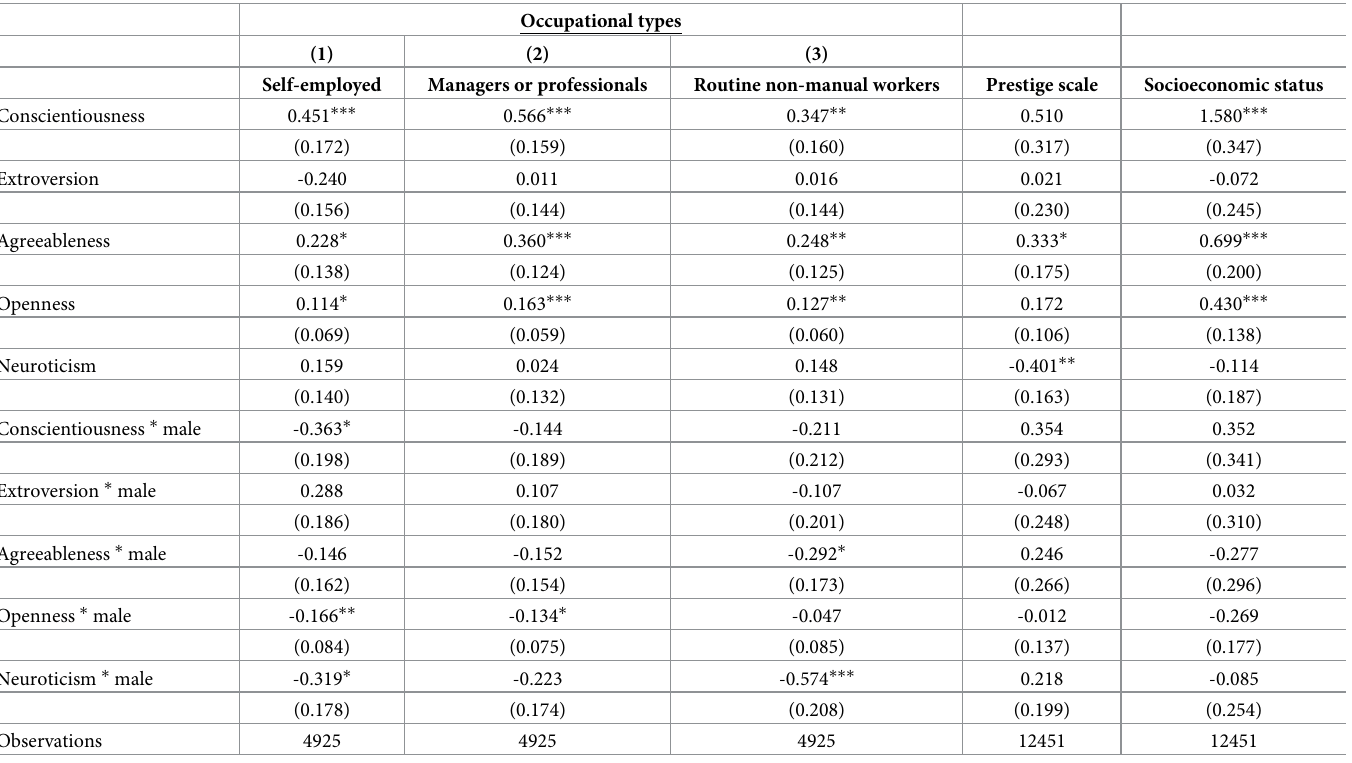
Table 7. Heterogeneity in terms of